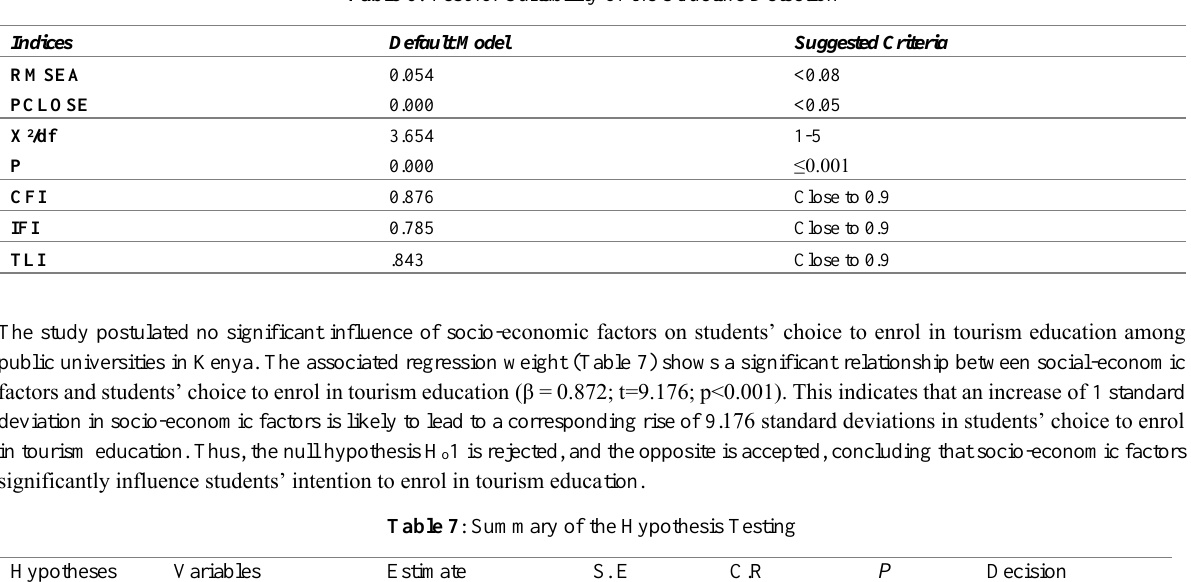
Table 6 : Test for Suitability of the Structure Detection